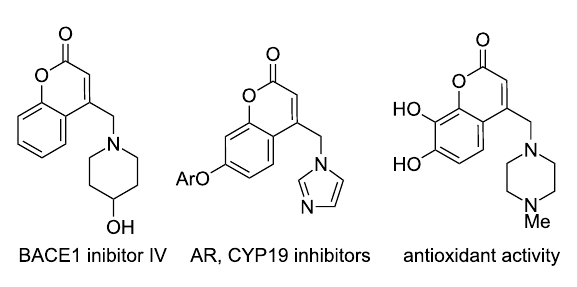
Figure 1: Representative biologically active aminomethylcoumarins.